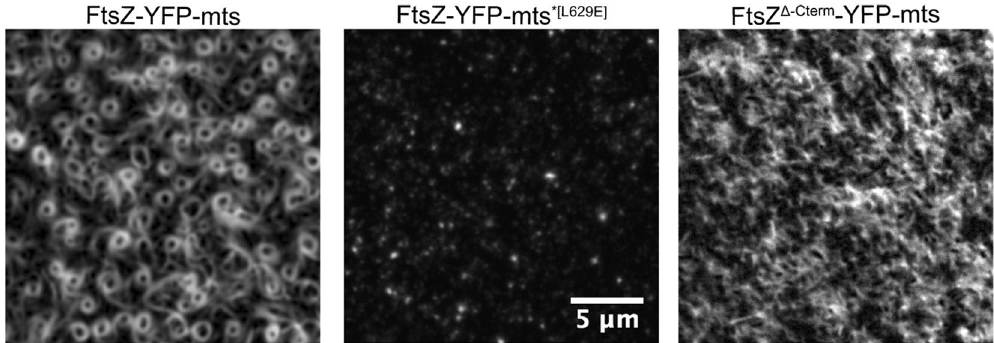
Figure 1. FtsZ-YFP-mts assembly into treadmilling rings is impaired when either membrane binding or the C-terminal linker is disrupted. Representative snapshots of the in vitro reconstitution of 0.5 µ M FtsZ-YFP-mts (left panel), 0.5 µ M FtsZ-YFP-mts * [L629E] (middle panel), and 1 µ M FtsZ Δ -Cterm -YFP-mts (right panel) on E. coli polar lipid extract membranes (4 mM GTP and 5 mM Mg 2 + ). (Middle panel) Rather than self-organizing into dynamic FtsZ vortices, FtsZ-YFP-mts * [L629E] binds as isolated patches to the E. coli polar lipid extract membrane. (Right panel) FtsZ Δ -Cterm -YFP-mts forms static filamentous structures on the supported lipid bilayer.